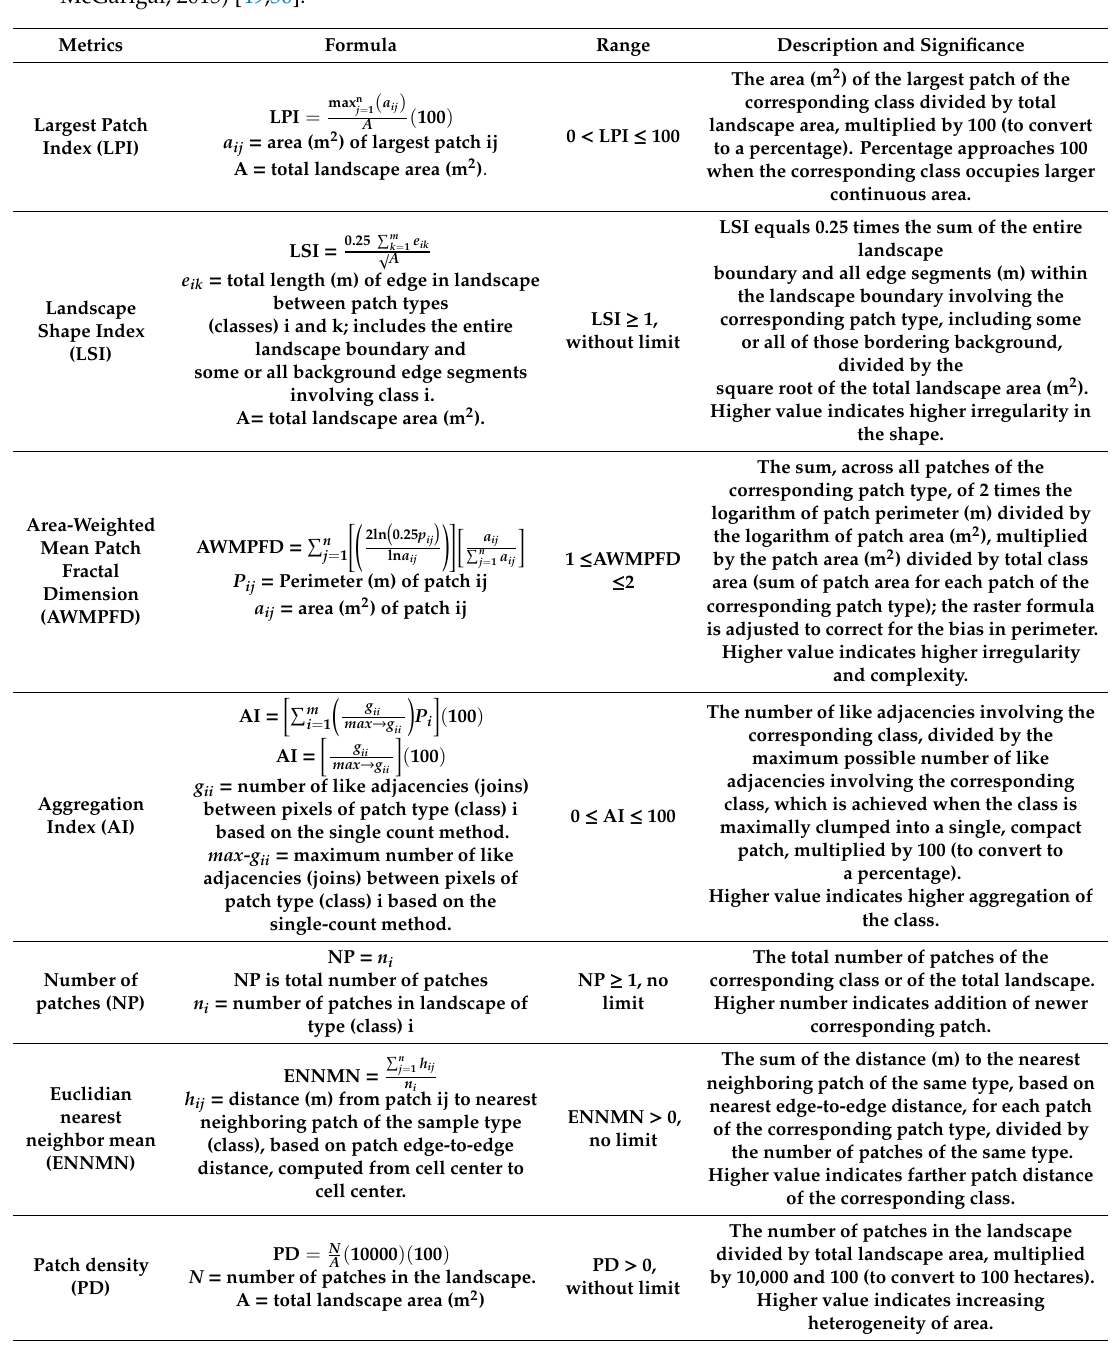
Table 1. List and definition of applied spatial metrics in the study, (after McGarigal and Marks, 1995; McGarigal, 2015)